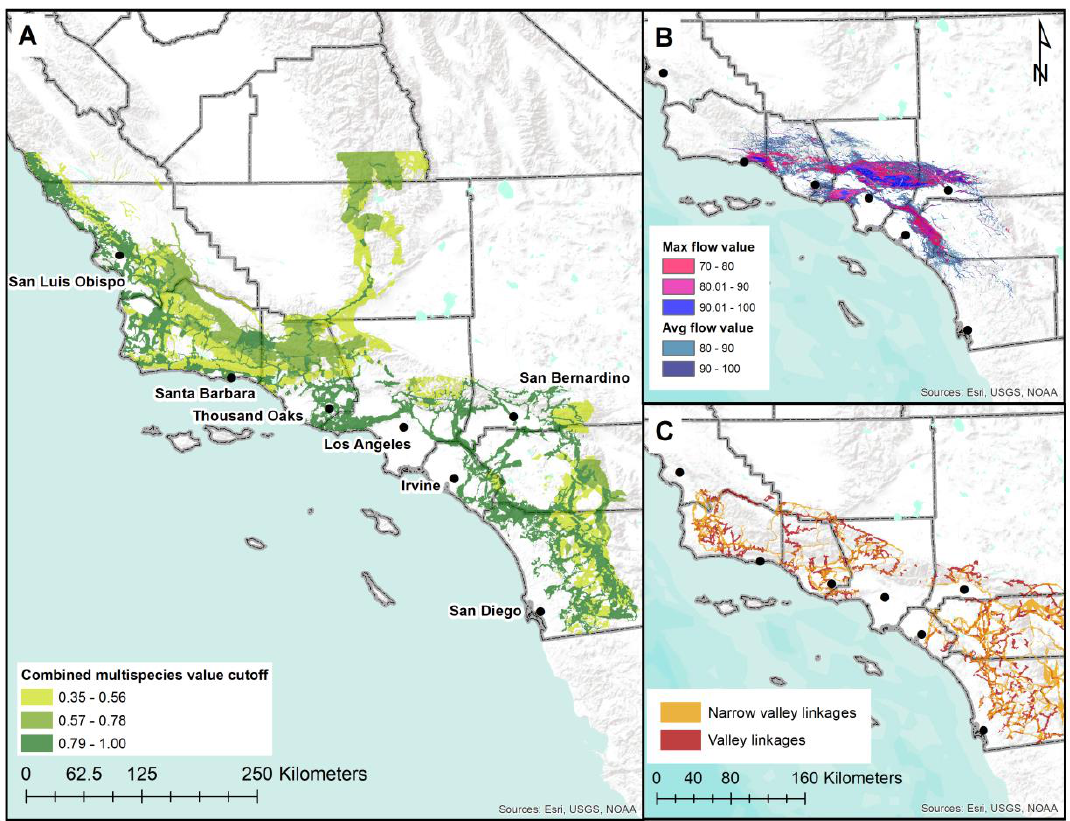
Figure 4. Maps depicting the outputs of the three linkage modeling approaches used to assemble the final linkage network. ( A ) Shows the selected threshold for the prioritized least cost corridor models; ( B ) Depicts Circuitscape outputs reflecting the combined top 20% of the average normalized percent flow and top 30% of the maximum percent flow for all species; ( C ) Identifies the selected geodiversity land facet linkages through valleys and narrow valleys.